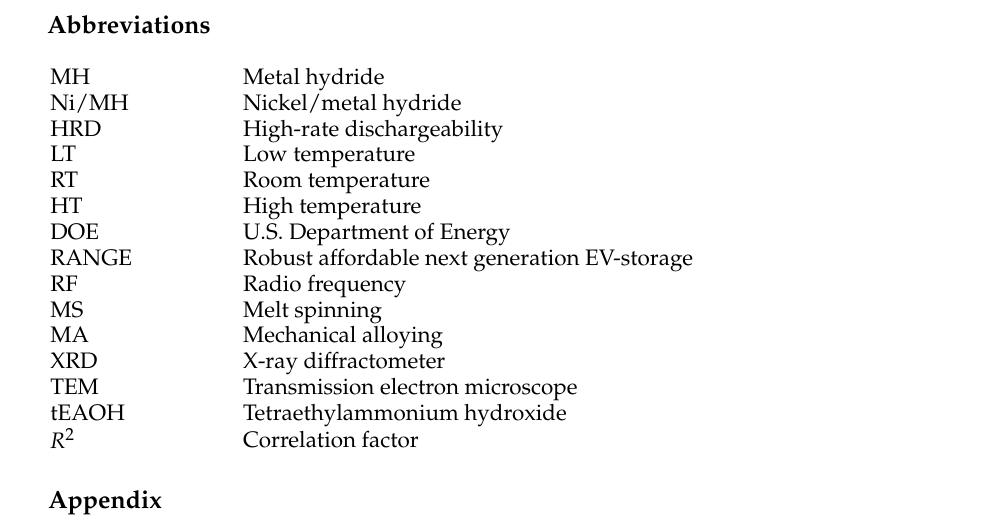
Table A1. Room temperature conductivities of electrolytes with various concentrations of KOH and other hydroxides normalized to that of 6 M KOH aqueous solution. Electrolyte with conductivity value higher than 100% implies that it is more conductive compared to the standard electrolyte (6 M KOH aqueous